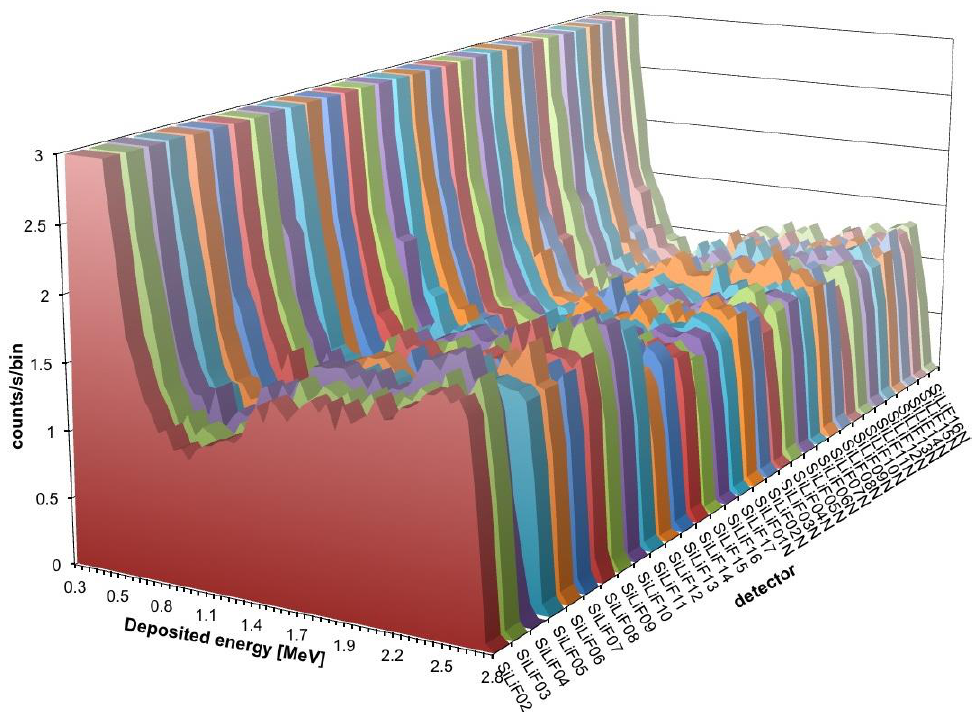
Figure 10. The characteristic spectrum shape, measured for all the SiLiF detectors in the front position, is due to the superposition of the triton (2.73 MeV) and alpha (2.05 MeV) contribution smeared down by the effect of the emission from different depths/angles in the 6 LiF converter. The energy bin size is 47 keV.